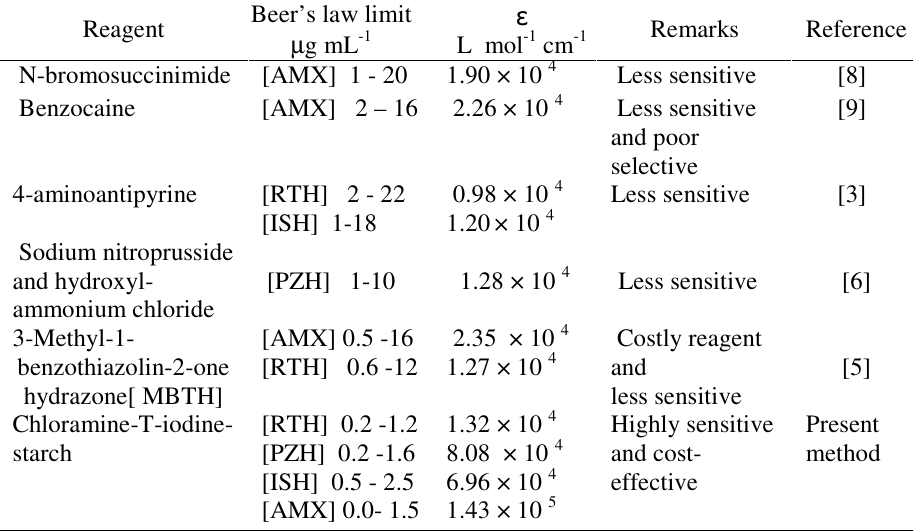
Table 4. Comparison with other reported